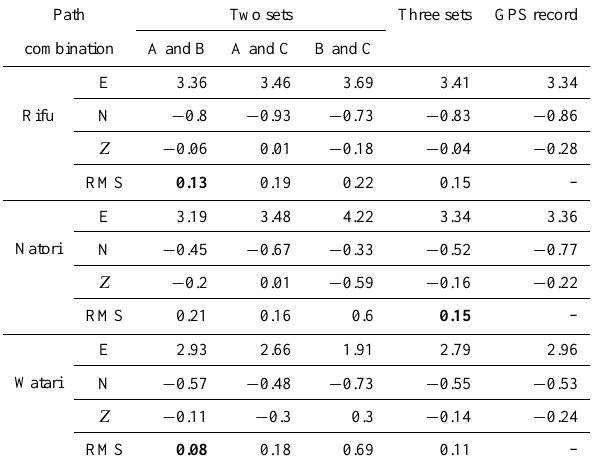
Table 3. Comparison of the estimated 3-D displacements from the regression analysis with those from GPS records. Three two-set combinations were evaluated using a 2.5km mesh, and two three- set combinations were assessed both by the mesh and individual buildings (units: m). Bold numbers represent the minimum value of RMS